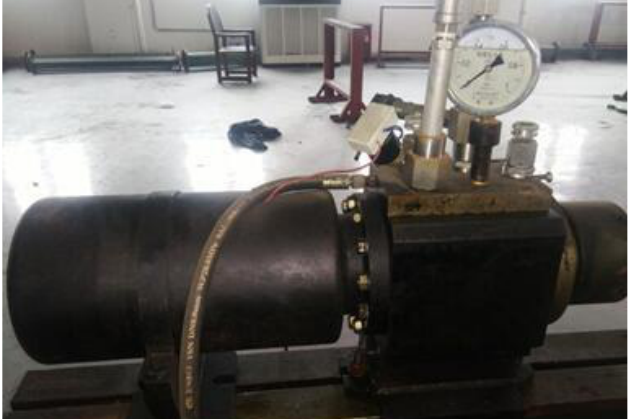
Figure 8. Power system.